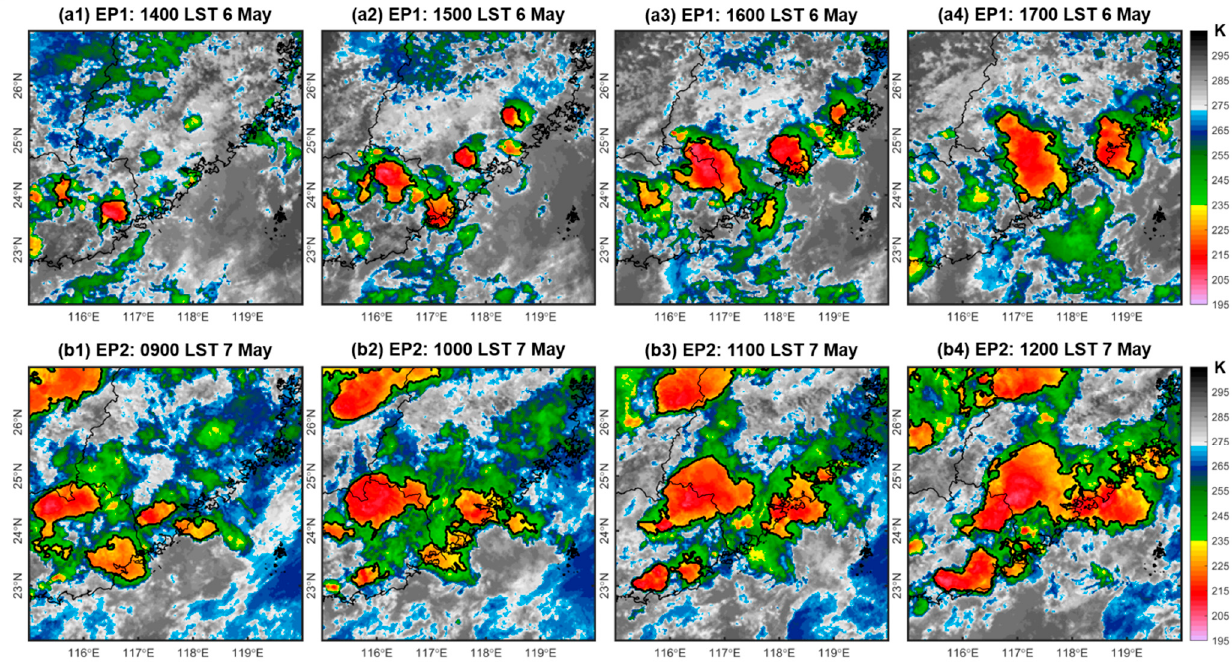
Figure 5. Hourly images of the infrared brightness temperatures (BTs; units: K) measured by Himawari ‐ 8 satellite with the identified MCS samples (areas enclosed by black solid lines) for ( a1 – a4 ) between 1400 and 1700 LST on 6 May 2018 in EP1 and ( b1 – b4 ) between 0900 and 1200 LST on 7 May 2018 in EP2. The provincial boundaries are denoted by gray curves.